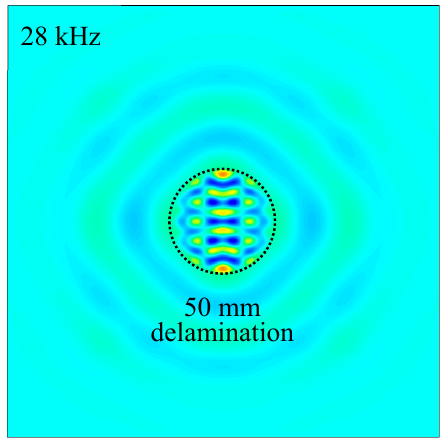
Figure 1. Example of using high-frequency local vibration to detect internal delamination in a laminated composite: 50 mm delamination excited at 28 kHz displays a clear local vibration mode that indicates the delamination size.